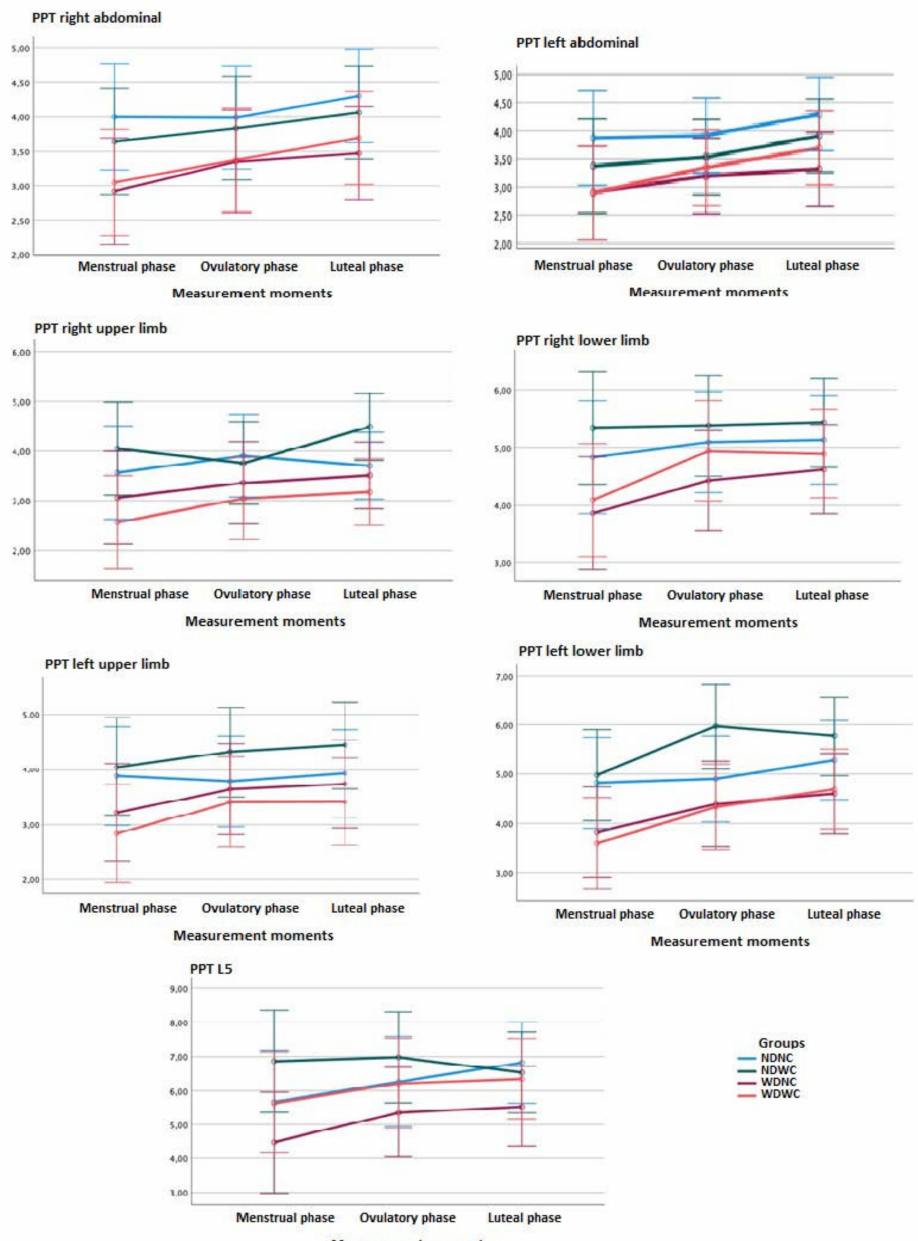
Figure 3. Linear graphs of the means completed with the error bars at 99% of the Cl, for the variable pressure pain threshold (PPT) that show the differences in the different measurement zones between the groups and the measurement moments (menstrual phase, ovulatory phase and luteal phase). For measurements in areas furthest from the upper and lower extremity pain, repeated measures two-way ANOVA (3 time-points × 4 groups) showed no statistically significant difference ( p > 0.01, F = 1.389; η 2 = 0.032) between groups, with a small effect size, as shown in Figure 3. Post hoc comparisons of the PPT in the right upper limb between the NDWC and WDWC groups in the luteal phase showed significant differences ( p < 0.01) with a large effect size ( d = 1.133), and post hoc comparisons of PPT in the left lower limb between groups in the ovulatory phase showed significant differences ( p < 0.01), with a large effect size ( d = 0.944–1.049), indicating a lower intensity of pain in the NDWC vs. WDNC group and in the NDWC vs. WDWC